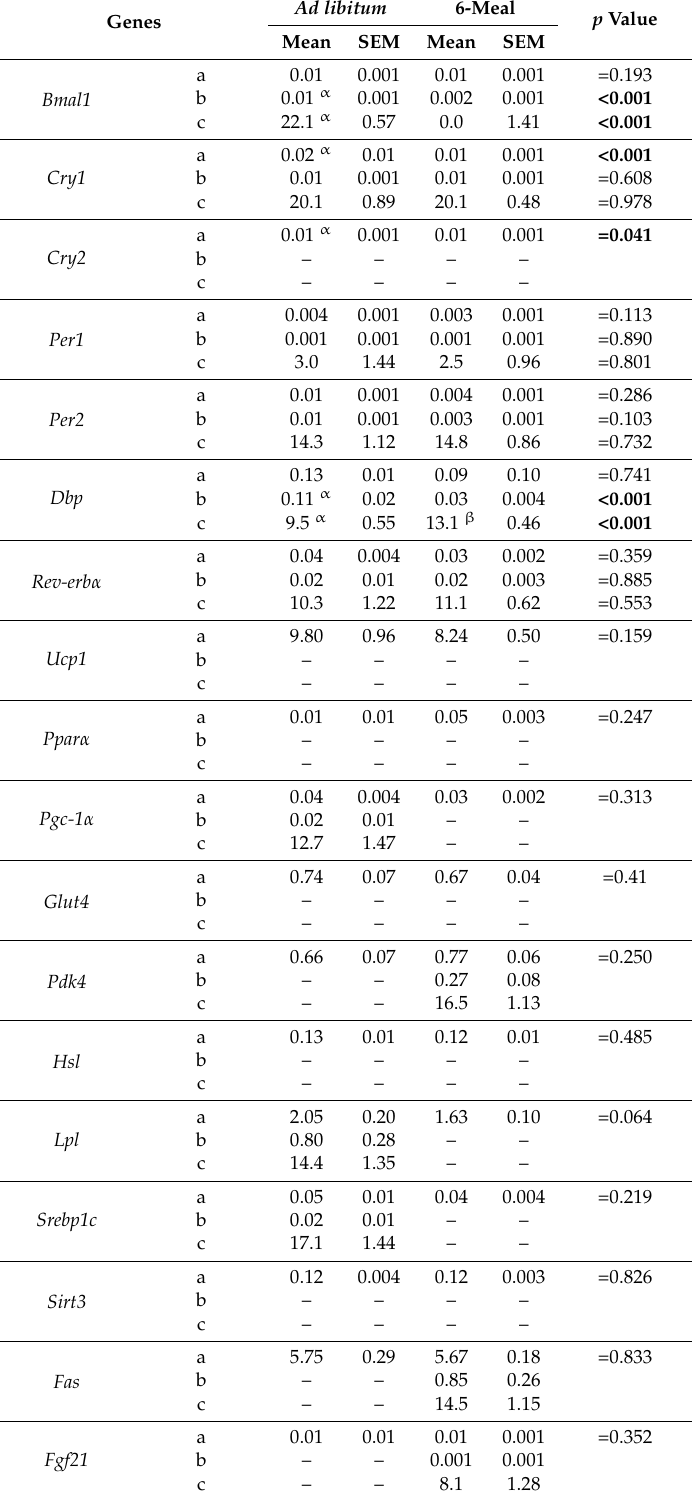
Table 3. t -Test analysis on cosinor parameters for clock and metabolic genes in the